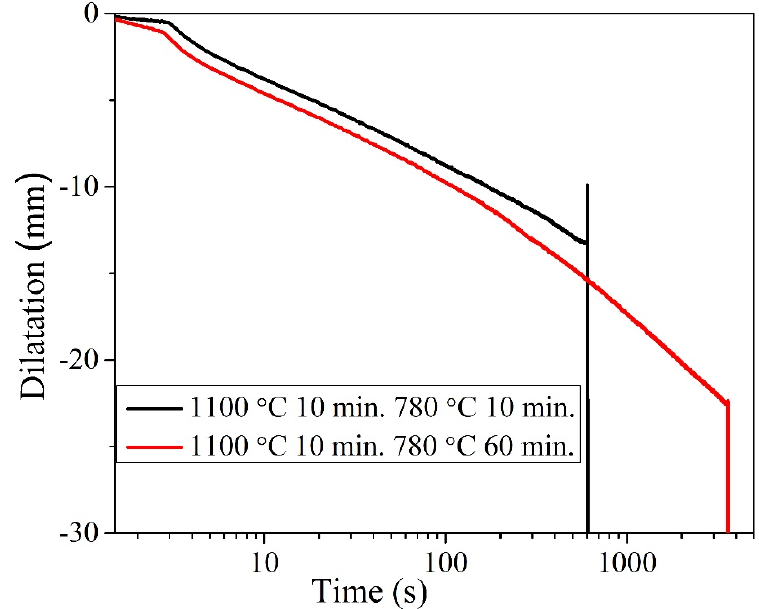
Figure 9. The dilatation time curve during isothermal holding at 780 °C with different durations, demonstrating that the reverse transformation continued with increase of isothermal holding time.